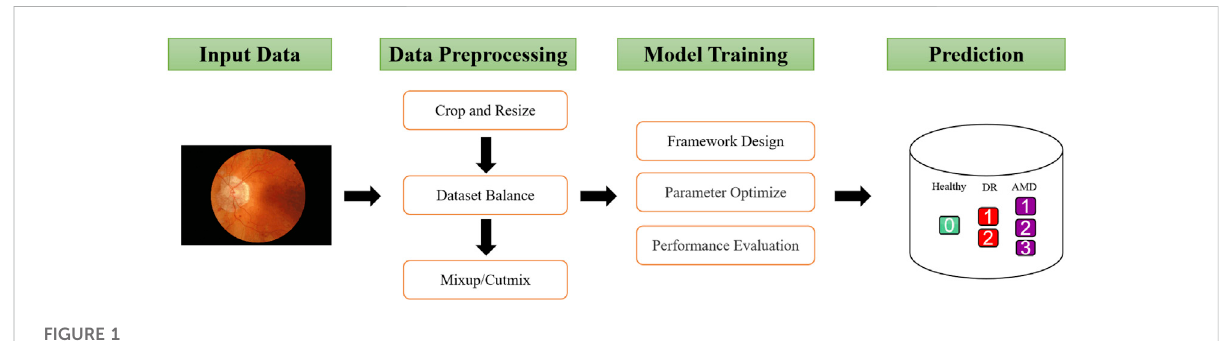
FIGURE 1 Overview of the proposed